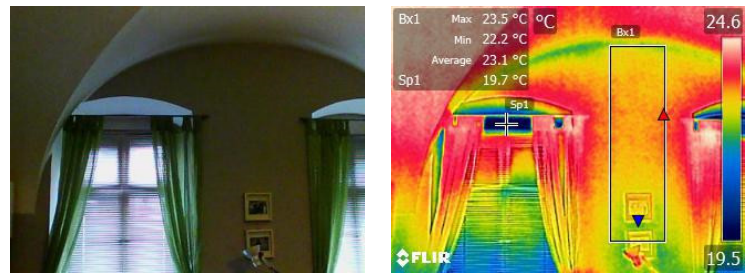
Figure 27. Thermal pattern on the inside of the wall.